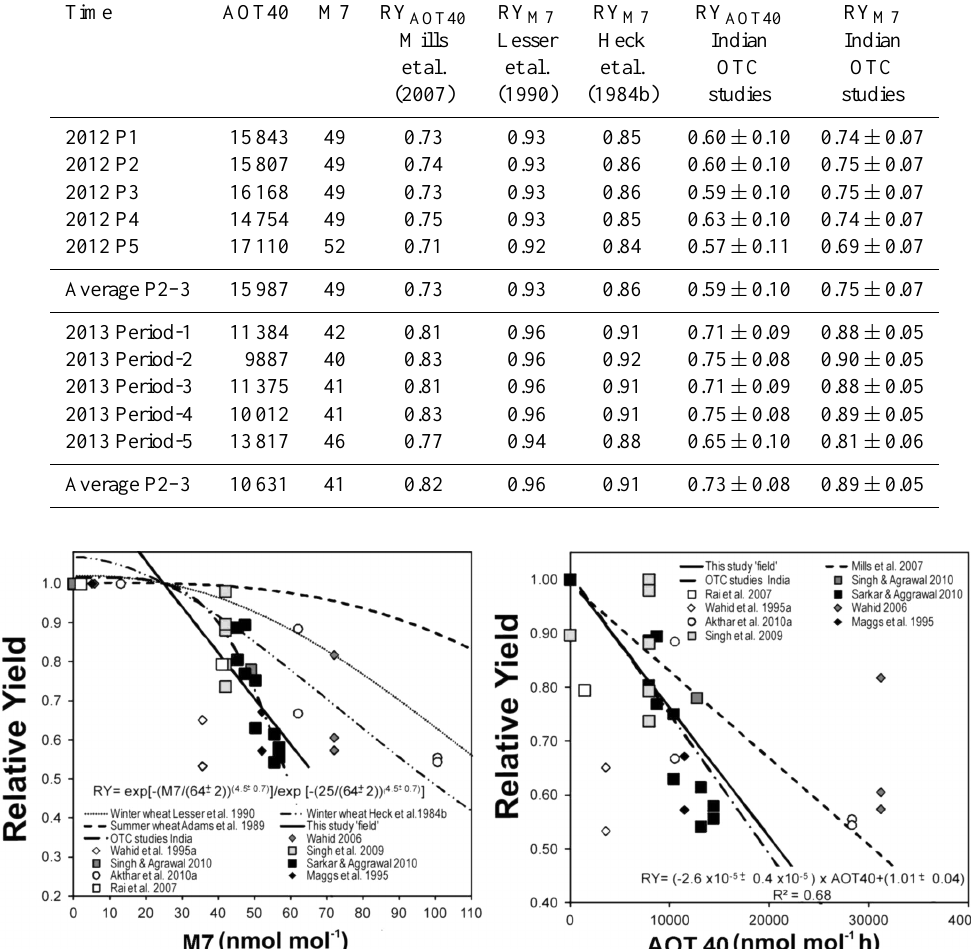
Figure 6. Comparison of the empirical exposure–response relationship based on field data (solid line) with OTC studies conducted in India (squares with line fit) and Pakistan (diamonds, not included in line fit). Circles show plant chamber studies on Bangladeshi wheat cultivars conducted in Japan. The exposure–response relationship based on American and European studies is plotted in the same graph for comparison. In all studies on southern Asian cultivars, wheat was exposed to elevated ozone levels from emergence to harvest, while the European and American exposure–response curves include data sets acquired on wheat crops that were exposed to elevated ozone during the last 3 months prior to